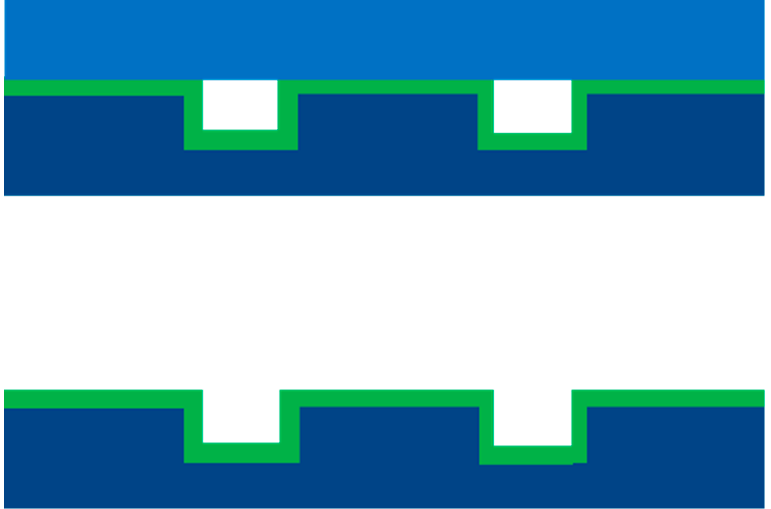
Figure 2. Schematic diagram of ALD-deposited cobalt-based catalyst before and after anodic bond- ing .